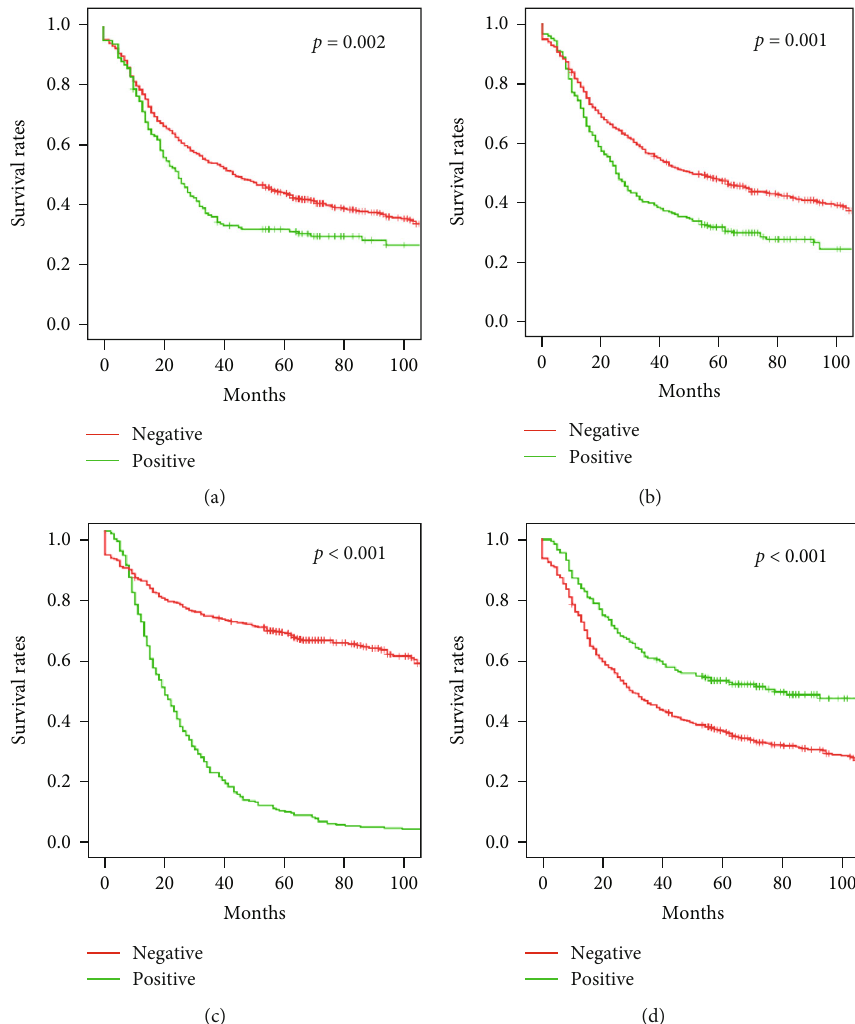
Figure 3: Survival of patients with upper gastric cancer: (a) lymphovascular tumor emboli, p = 0 : 002 ; (b) serosal invasion, p = 0 : 001 ; (c) recurrence and metastasis, p < 0 : 001 ; (d) adjuvant chemotherapy, p < 0 : 001 .